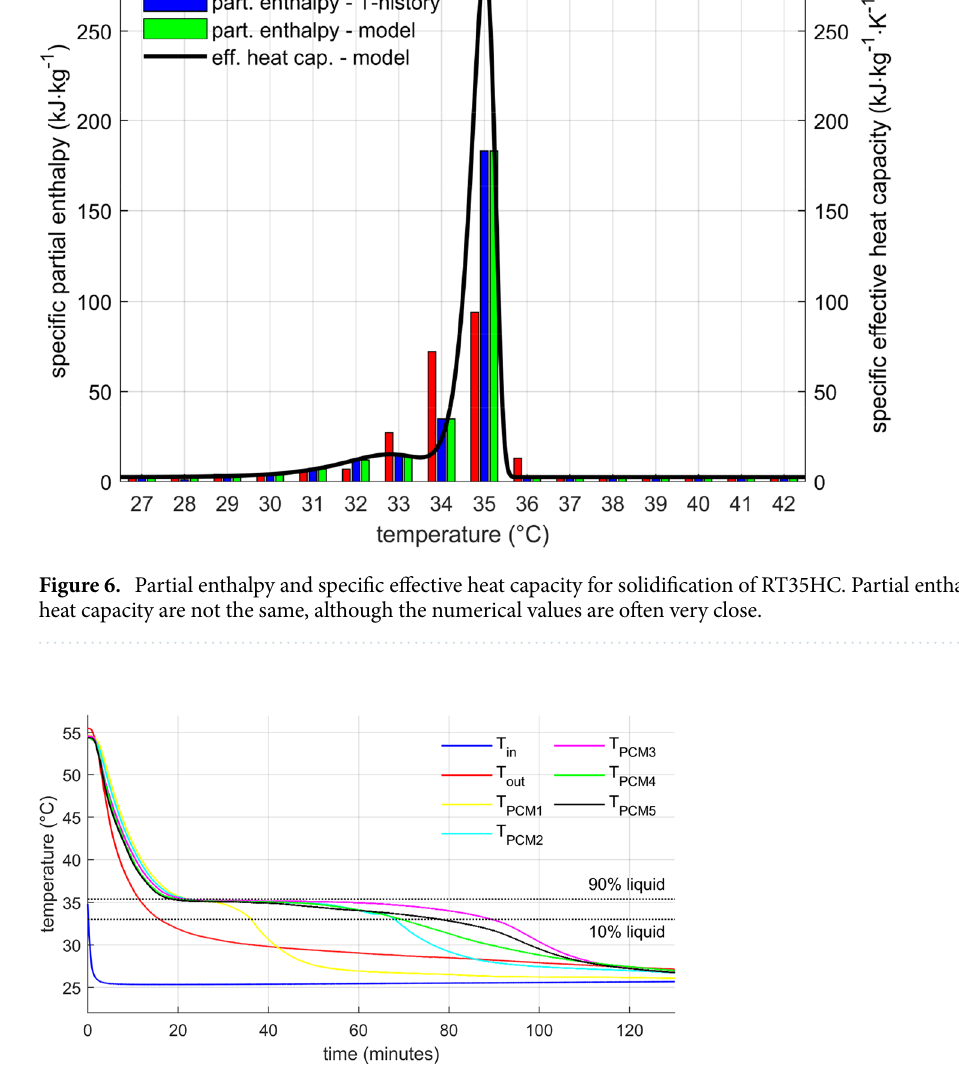
Figure 7. HTF (inlet and outlet) and PCM (five positions in the capsule from top to bottom) temperature evolution for lower HTF mass flow rate. The PCM phase transition zone marked by 10% and 90% liquid ratio